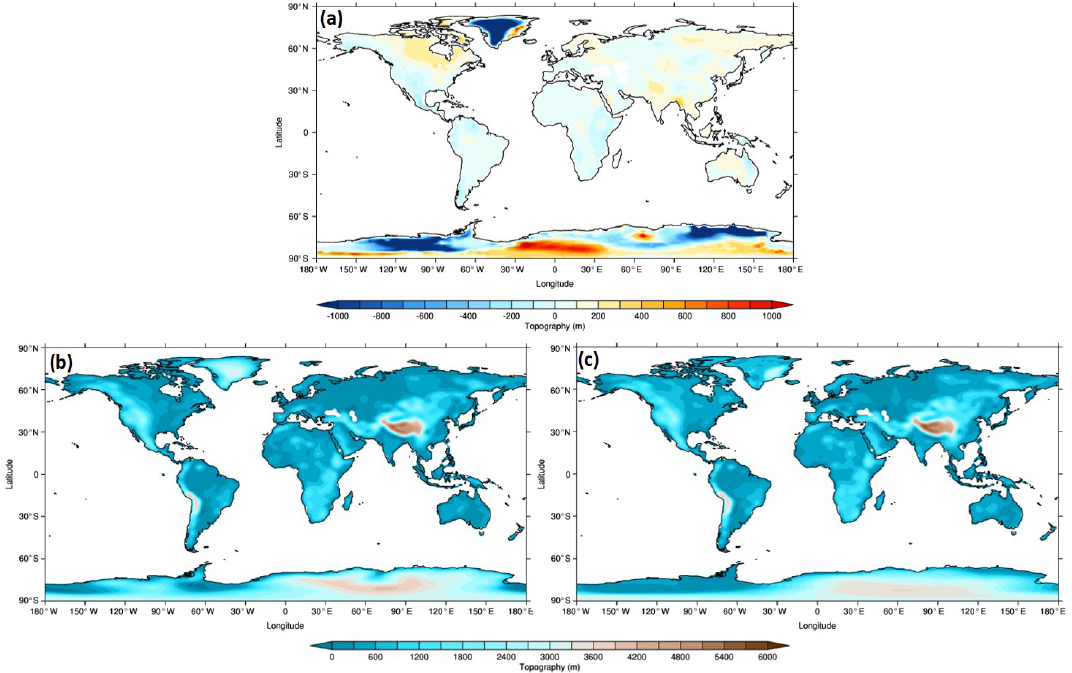
Figure 1. Changes to topography in HadGEM3 mPWP simulation: (a) PRISM4 anomaly, (b) original field used in the HadGEM3 piControl ,